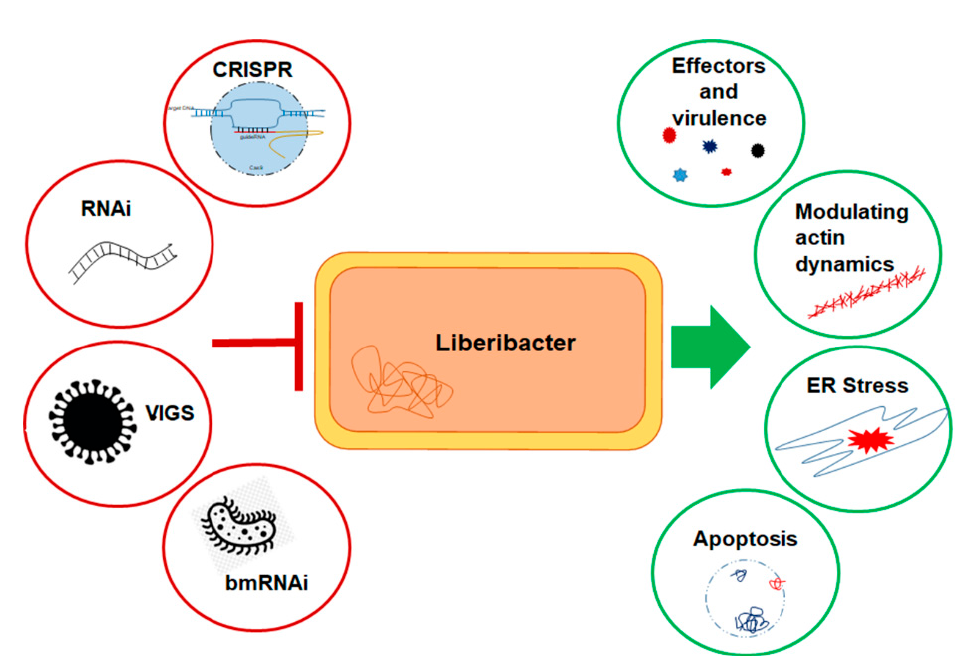
Figure 2. Simplified depiction of the novel strategies to inhibit Liberibacter infection and its effects on the insect host. Liberibacter modulates host cellular mechanisms in various mechanisms for successful dissemination and transmission, often leading to host cell damage (green circles). Multiple tools can be designed (red circles) to disrupt liberibacter–psyllid interactions as an effective management strategy.